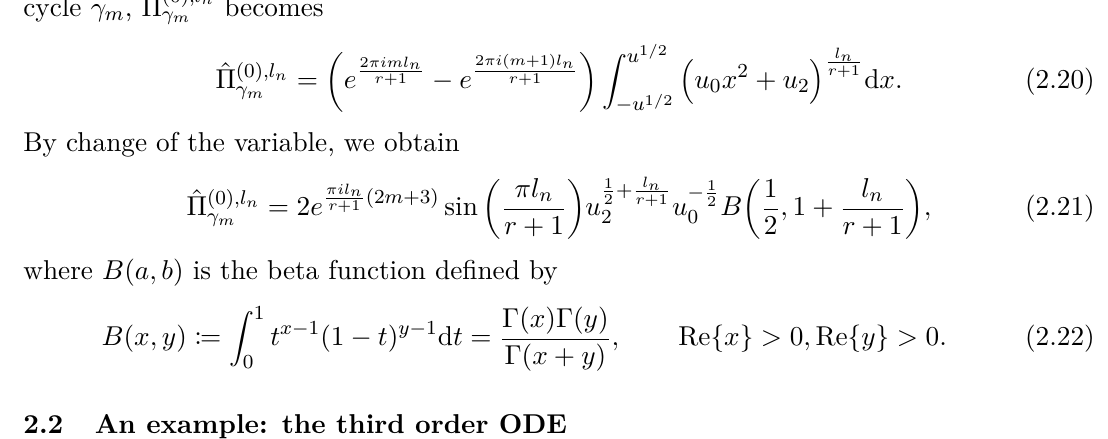
Figure 1. The cycle γ m . The solid line is on the m -th sheet while the dashed line is on the ( m + 1) -th sheet of the WKB curve Σ